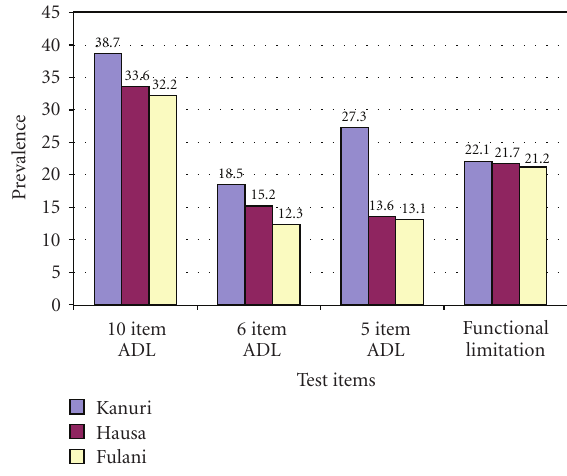
Figure 1: Prevalence of physical disability and functional limitation by ethic group among Nigerian rural